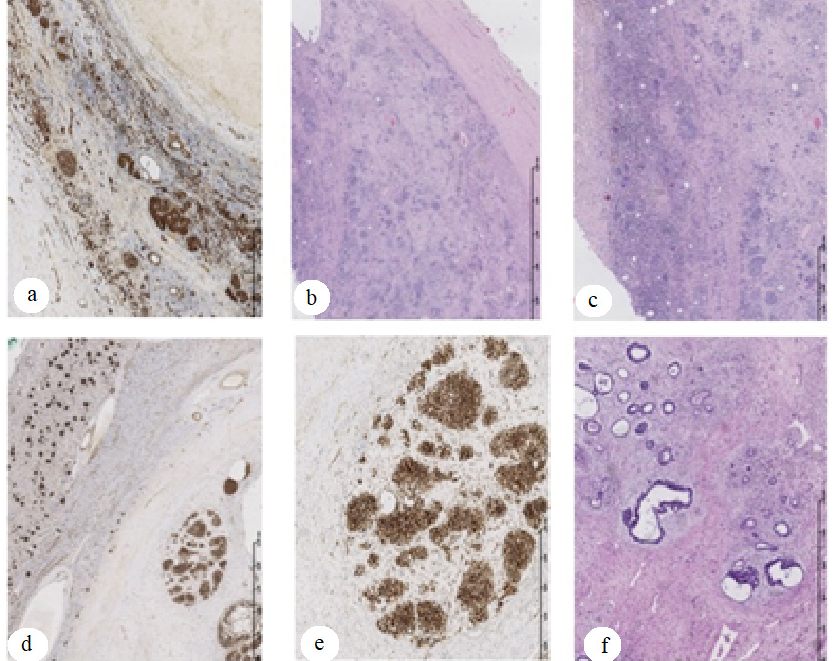
Figure 2. Wilms tumor mixed type with intermediate risk. Tumor specimen examination after 6-week preoperative chemotherapy. HE staining showed residual blastemic-epithelial compartment with regression areas. Immunohistochemistry with WT1 antibody showed residual blastemic nodules with epithelial elements; slides ( a – c )—the tumor tissue sections of the first sister; slides ( d – f )—the tumor tissue sections of the second sister. Slides ( b , c , f )—HE staining, magnification ×20. Slides ( a , d , e )—WT1 antibody (Origene) immunohistochemistry analysis in formalin-fixed and paraffin- embedded tumor tissue followed by peroxidase conjugation of the secondary antibody and DAB staining; magnification × 20 for slides ( a ) and ( d ) and × 40 for slide ( e